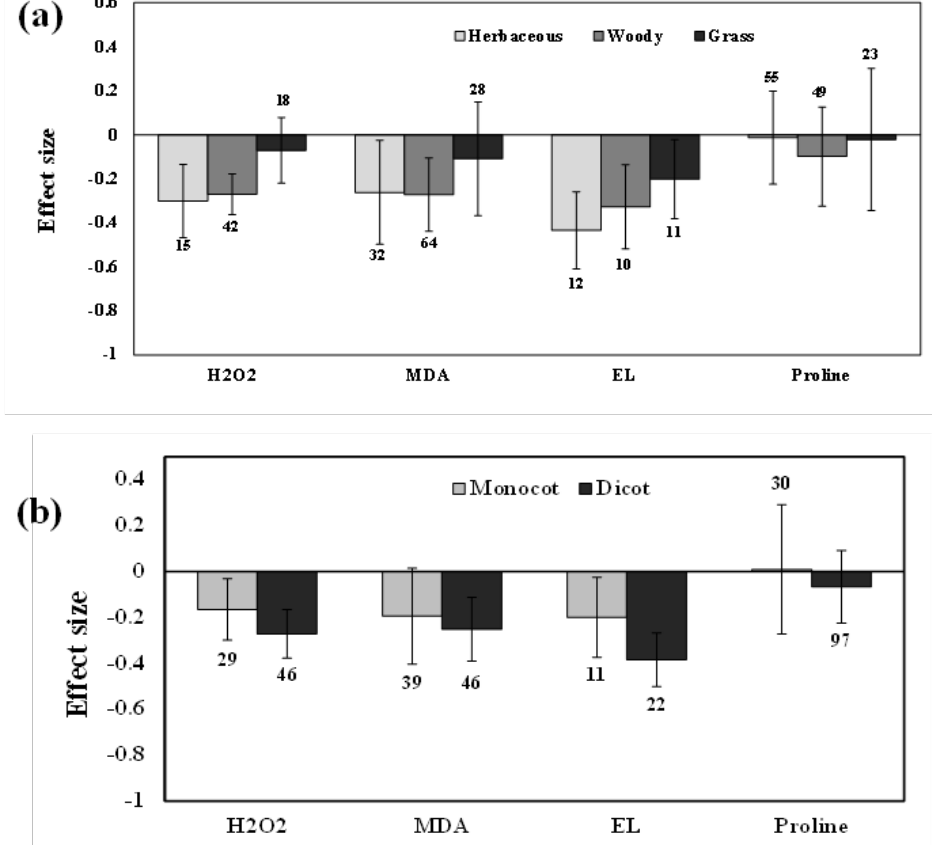
Figure 6. Categorical analysis of plant functional groups ( a ) and taxonomic groups ( b ) on H 2 O 2 , MDA, EL, and Proline levels. Error bars are means ± 95% confidence intervals (CIs). Where the CIs do not overlap the horizontal lines, the effect size for a response variable is significant at p < 0.05. The numbers of observations are shown above the bar. Note: H 2 O 2 − Hydrogen peroxide, MDA − Malondialdehyde, EL − Electrolyte leakage.